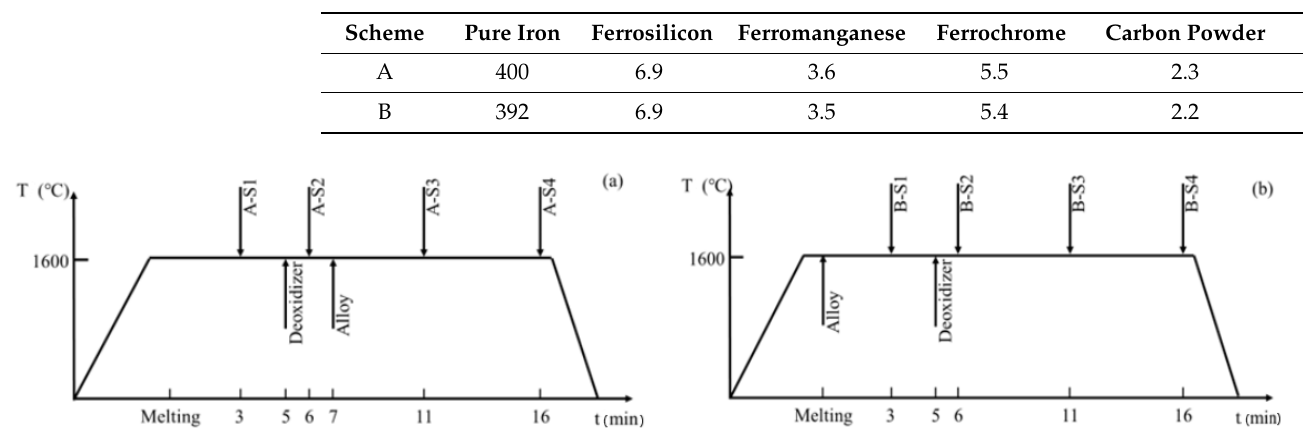
Table 3. Measured chemical composition of S4 samples in different schemes/wt.%.